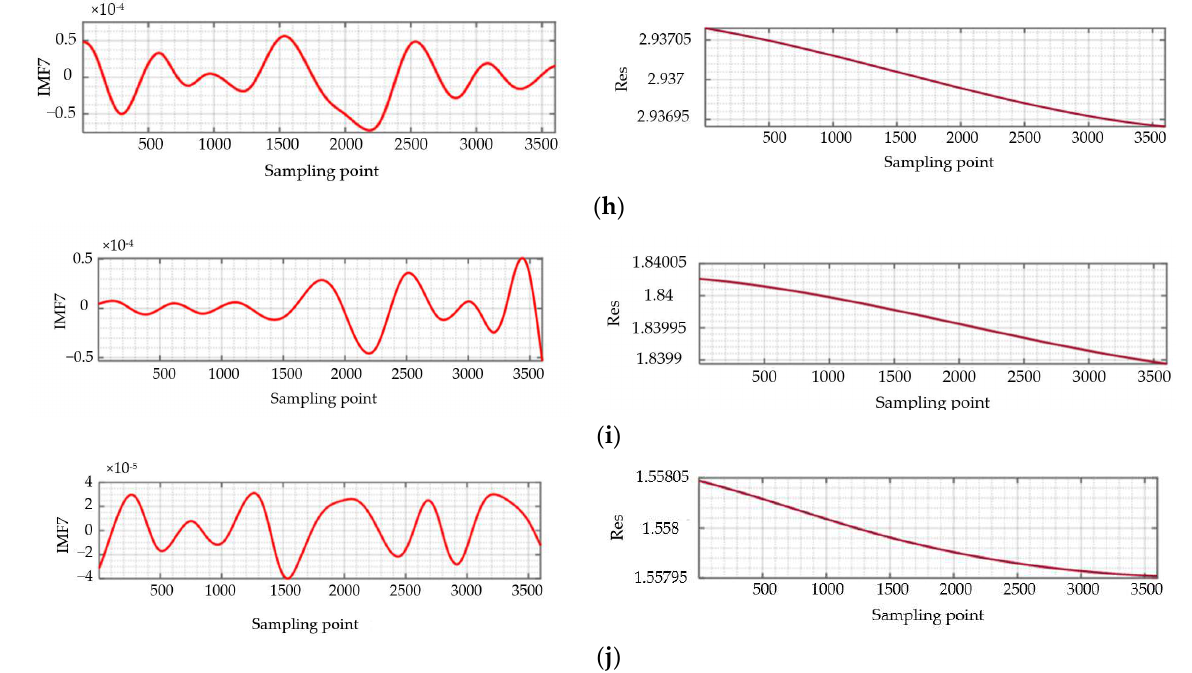
Figure 12. EMD decomposition results of ceramic ball surface original signal. ( a ) Decomposition results of Sample 1; ( b ) Decomposition results of Sample 2; ( c ) Decomposition results of Sample 3; ( d ) Decomposition results of Sample 4; ( e ) Decomposition results of Sample 5; ( f ) Decomposition results of Sample 6; ( g ) Decomposition results of Sample 7; ( h ) Decomposition results of Sample 8; ( i ) Decomposition results of Sample 9; ( j ) Decomposition results of Sample 10.